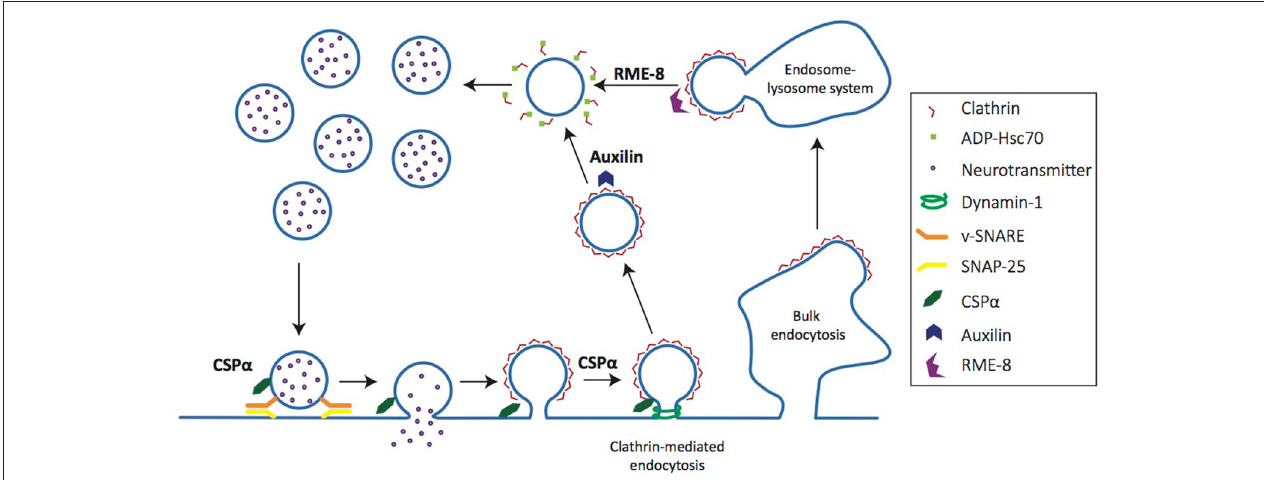
FIGURE 4 | Co-chaperones regulate distinct steps of the synaptic vesicle cycle. Cartoon depicts synaptic vesicle cycle. CSP α chaperones SNAP-25, a t-SNARE involved in vesicle fusion for neurotransmitter release. CSP α also chaperones dynamin-1, a GTPase necessary for vesicle scission in clathrin-mediated endocytosis. Auxilin acts on clathrin-coated vesicles, uncoating them to generate nascent vesicles that are returned to the recycling pool. RME-8 regulates clathrin uncoating at the early